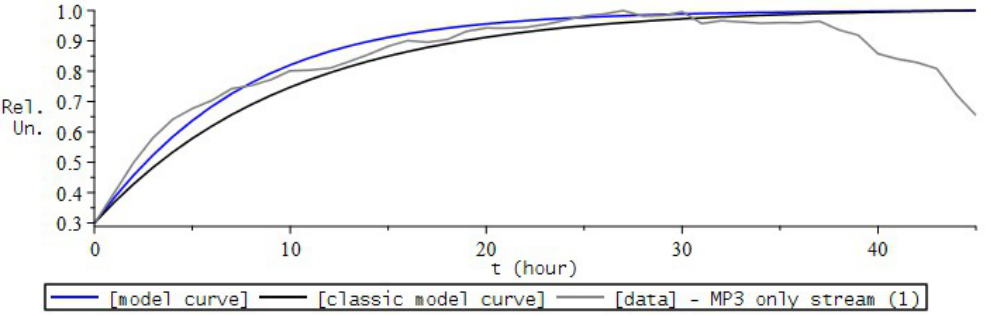
Figure 20. Correlation coefficients: 89.9% for the proposed (17) model (blue), and 86.9% for the classic (15) model (black).